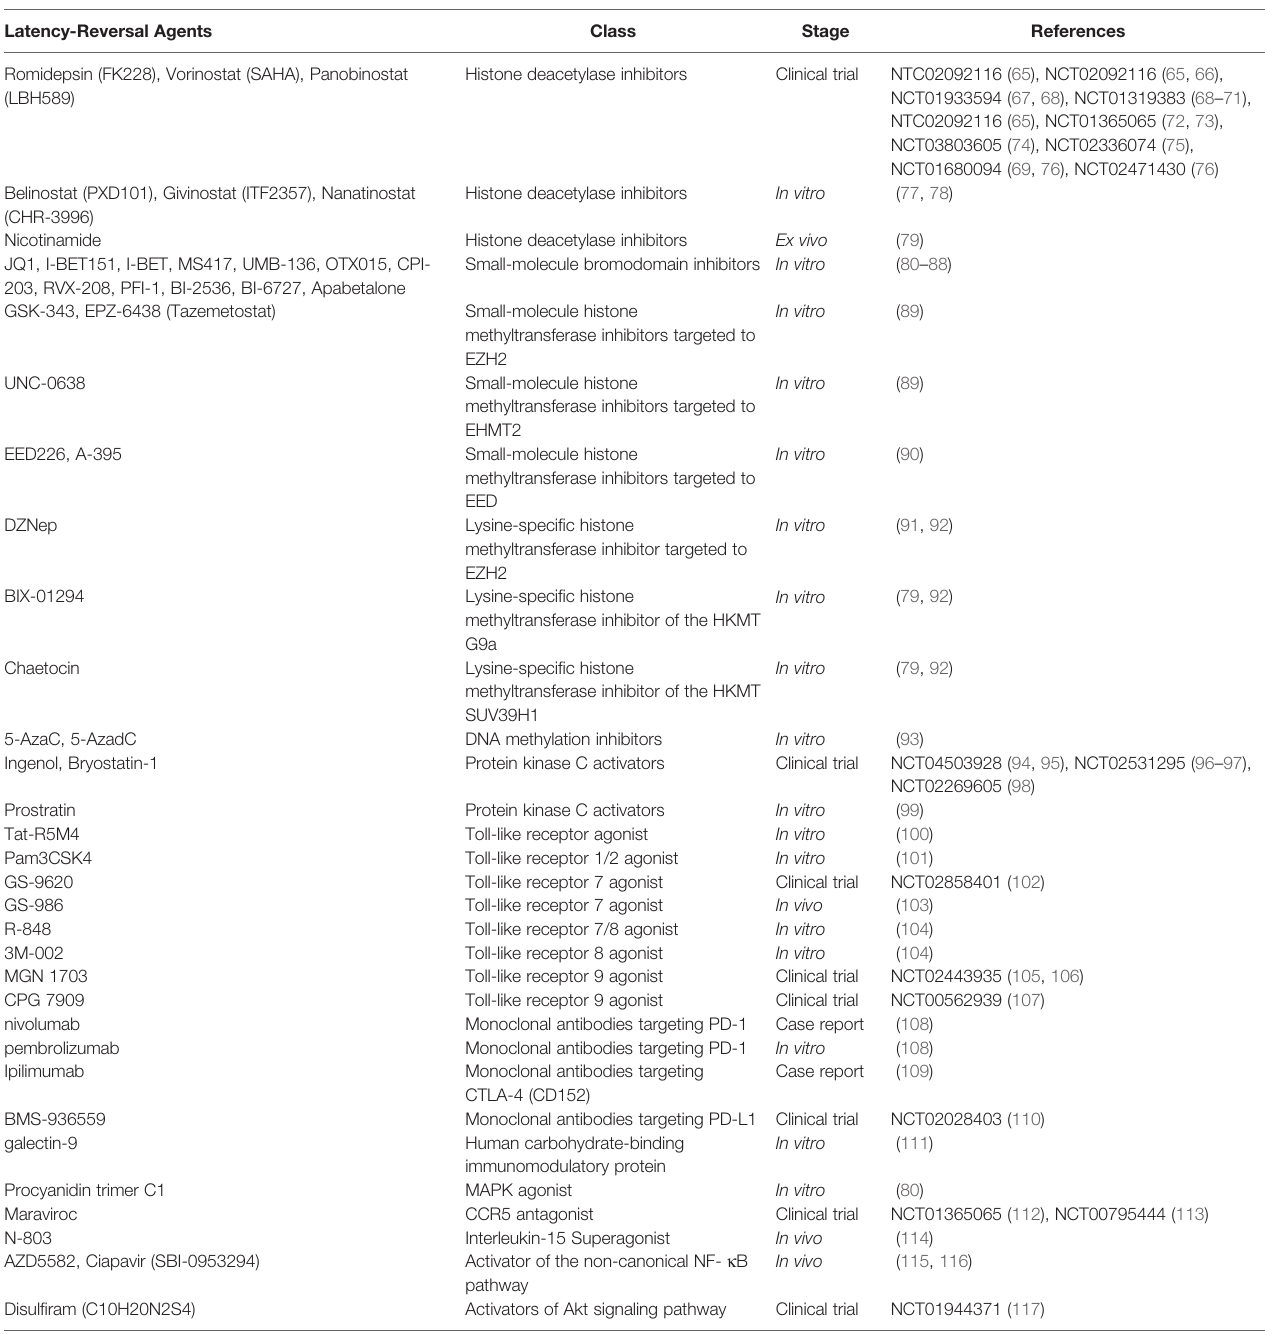
TABLE 3 | Summary of Latency-Reversal